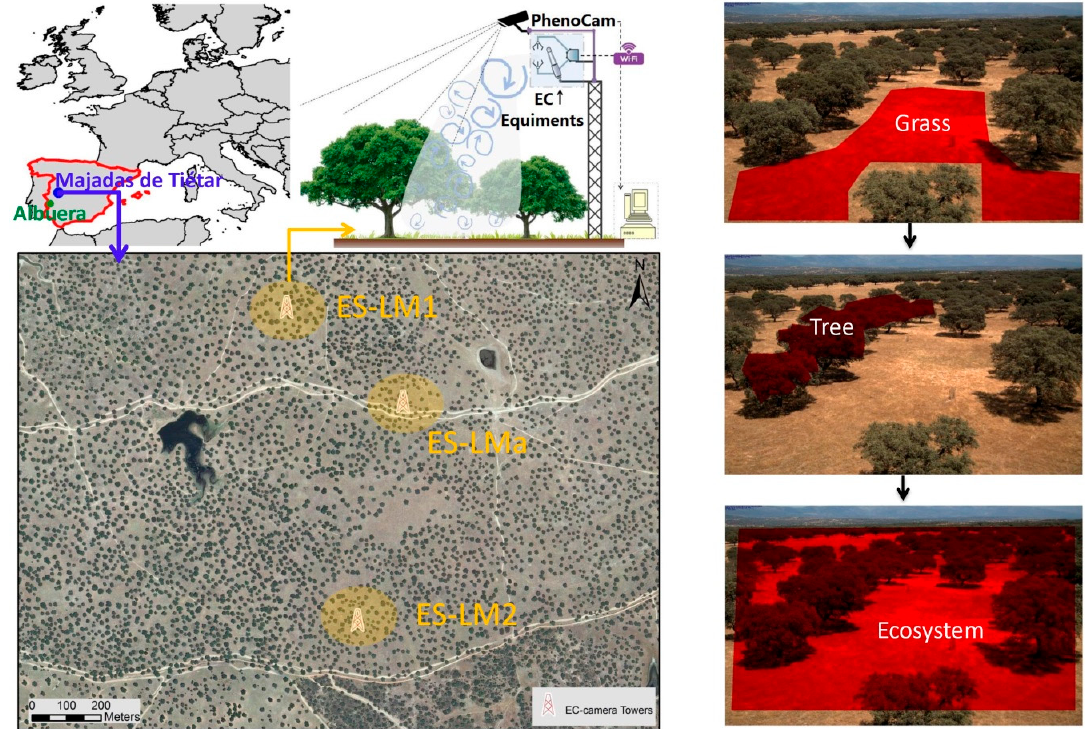
Figure 1. Experimental setup at Majadas de Tiétar and La Albuera in the Spain ( left panel ) and an example of regions of interest (ROIs) in each experimental site ( right panel ): Grass, Tree, and Ecosystem ROIs, respectively. At each site, an eddy covariance (EC) system was installed at a height of 15 m to measure the fluxes of the whole ecosystem. A near-infrared-enabled camera was installed at 15 m beside the EC system to take pictures half-hourly between 10:00 and 14:30. Three EC towers are in the Majadas de Tiétar (FLUXNET IDs are ES-LM1, ES-LM2, and ES-LMa, respectively) and an EC tower in the La Albuera (FLUX ID: ES-Abr), respectively (not shown). The map of Majadas de Tiétar was provided courtesy of the Spanish Program of Aerial Orthophotography.